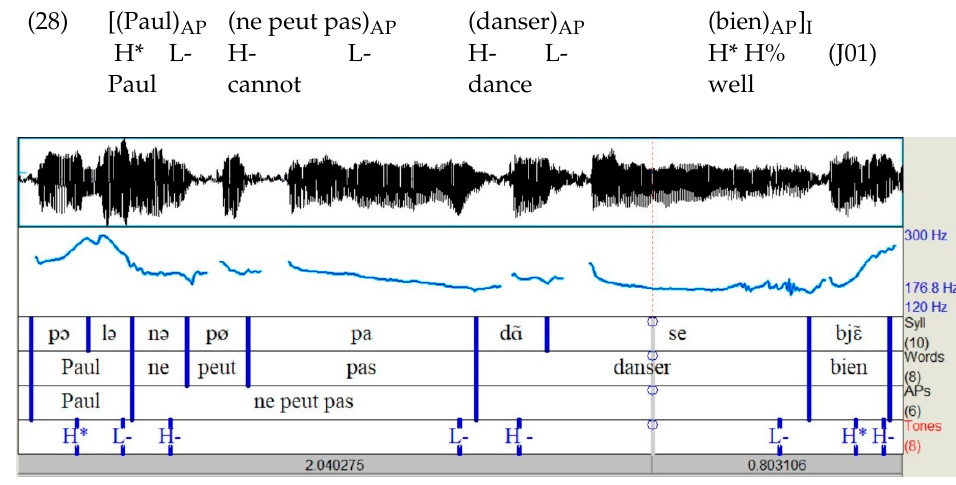
Figure 2. Waveform and pitch track associated with (28).